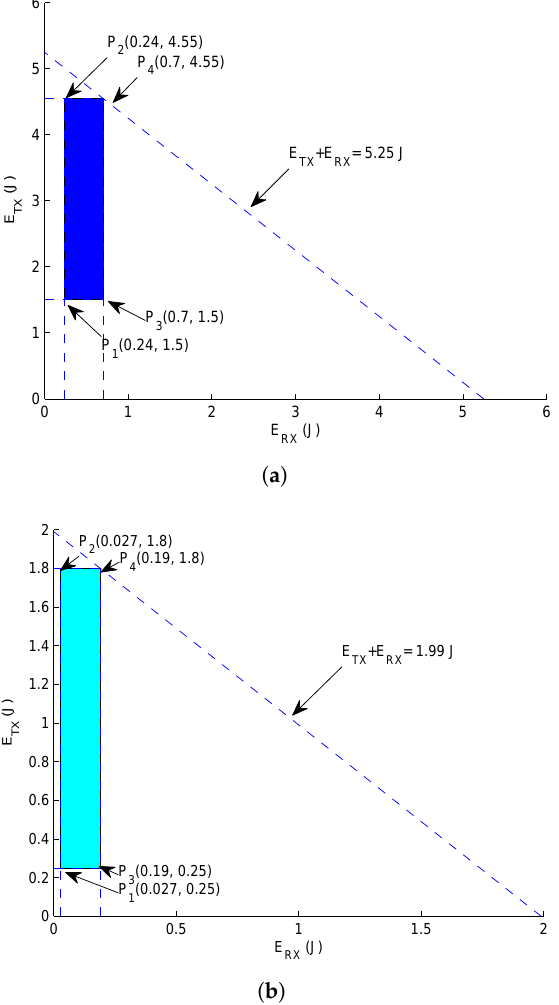
Figure 5. Feasible regions. ( a ) Feasible region for energy tax minimization (GDGOR-IA); ( b ) feasible region for energy tax minimization